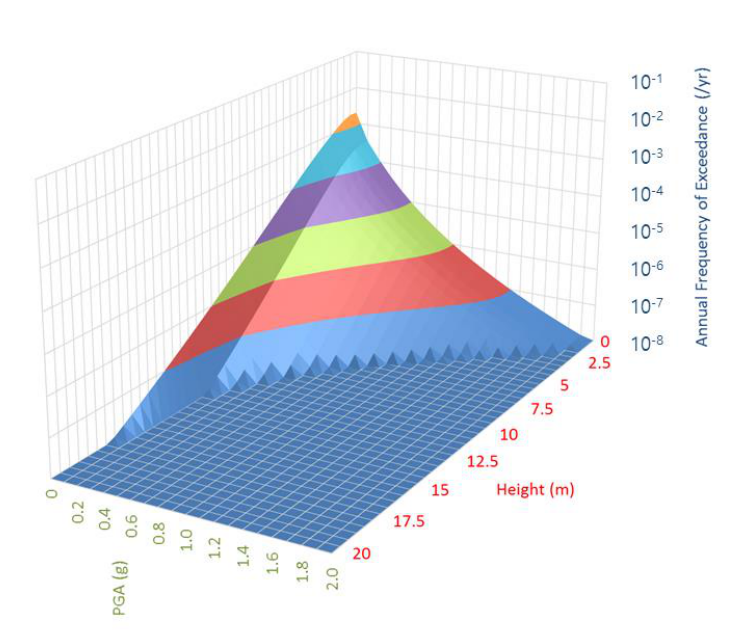
Figure 13. Seismic-tsunami multi-hazard surface information.